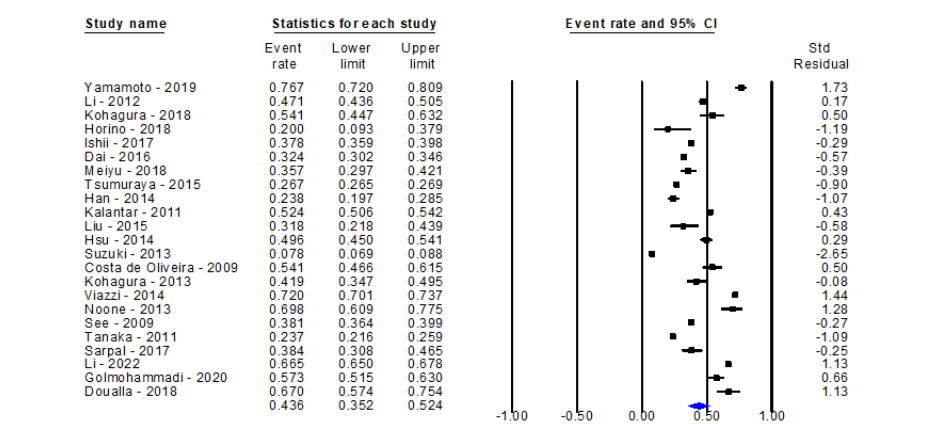
Figure 2. Pooled prevalence of hyperuricemia among chronic kidney disease patients worldwide. Std: standard Geography specific prevalence